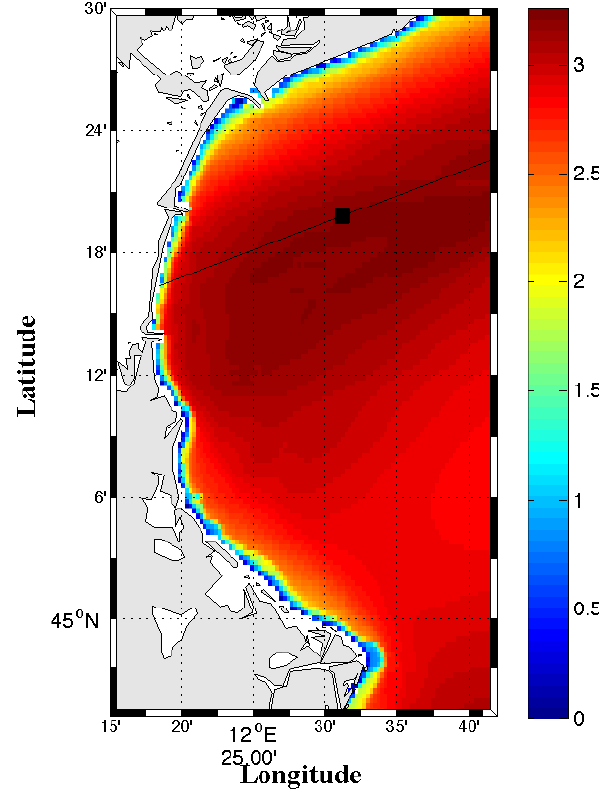
Figure 16. Test-case 1: field of H m 0 produced by SWAN B78 at the peak of the storm on 29